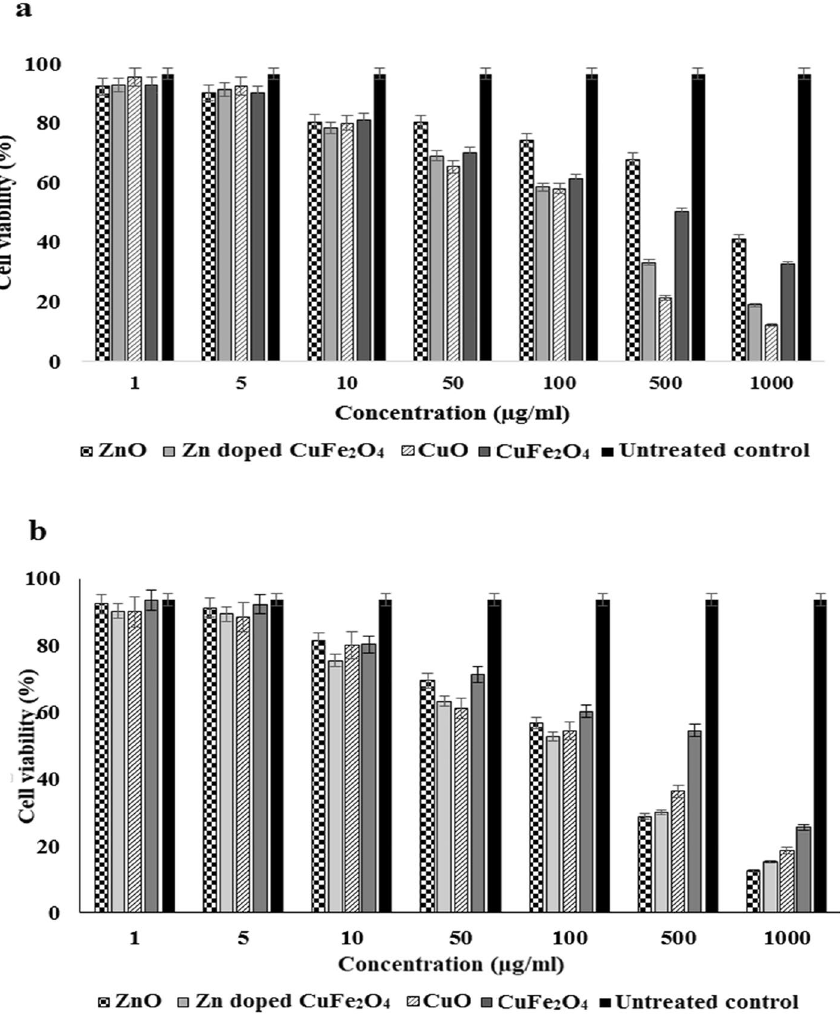
Figure 5. Cytotoxicity analysis: ( a ) the cytotoxicity of NPs against murine macrophages (J774 cells), and ( b ) the cytotoxicity of NPs on A549 lung cancer